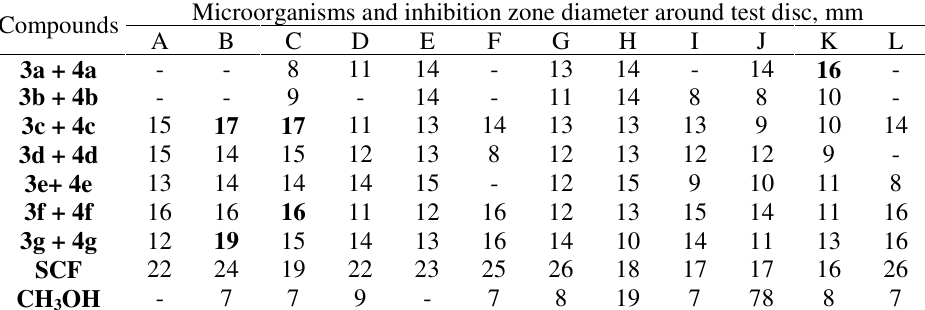
Table 2. Antimicrobial activity inhibition of diastereomers of 3 + 4. Microorganisms and inhibition zone diameter around test disc, mm Compounds A B